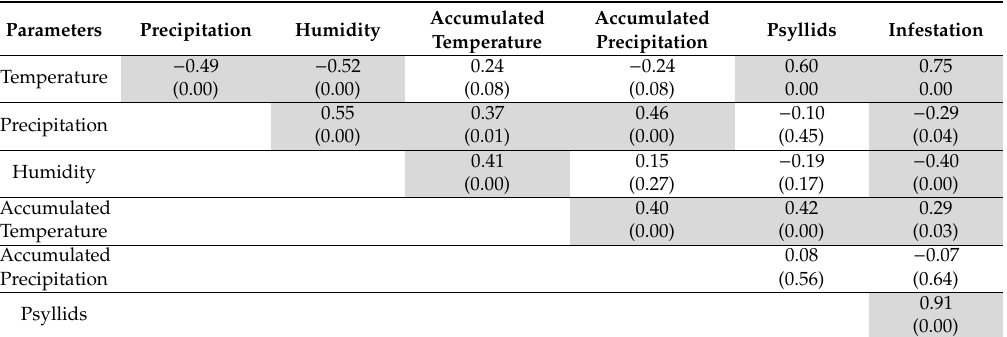
Table 2. Correlation matrix of the meteorological variables and biological data deriving from “psyllid sampling” and “infestation sampling”, based on monthly groupings. Correlation coe ffi cients and the p values (in brackets) are given (significant pairs = grey shaded). For pairs with p values greater than 0.05, there is no significant relationship between the two variables; N =